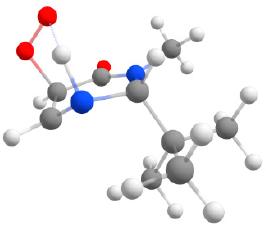
Figure 10. TS2 Z from QST2 calculation starting from the I Z as reactant and the hydroperoxide as product P (E = –687.571828 Hartree).